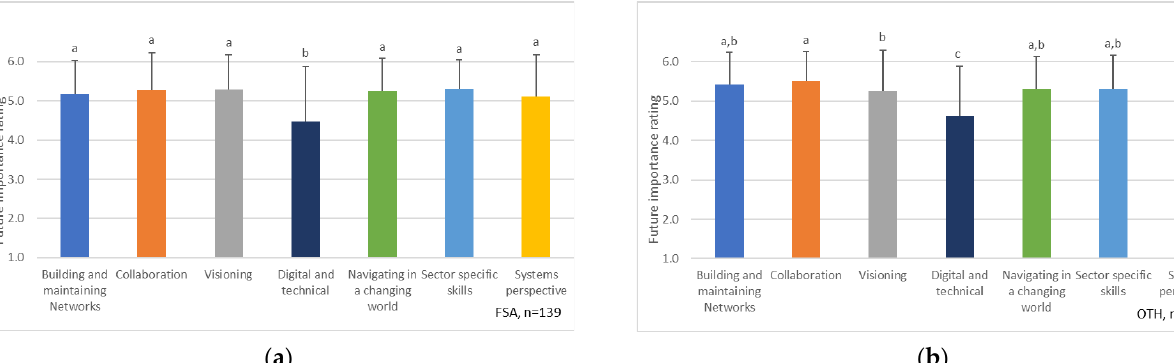
Figure 1. Average ratings and SD of the future importance of seven skills according to ( a ) FSA stakeholders ( n = 139) and ( b ) OTH stakeholders ( n = 326). The same letter above a bar indicates no significant difference.